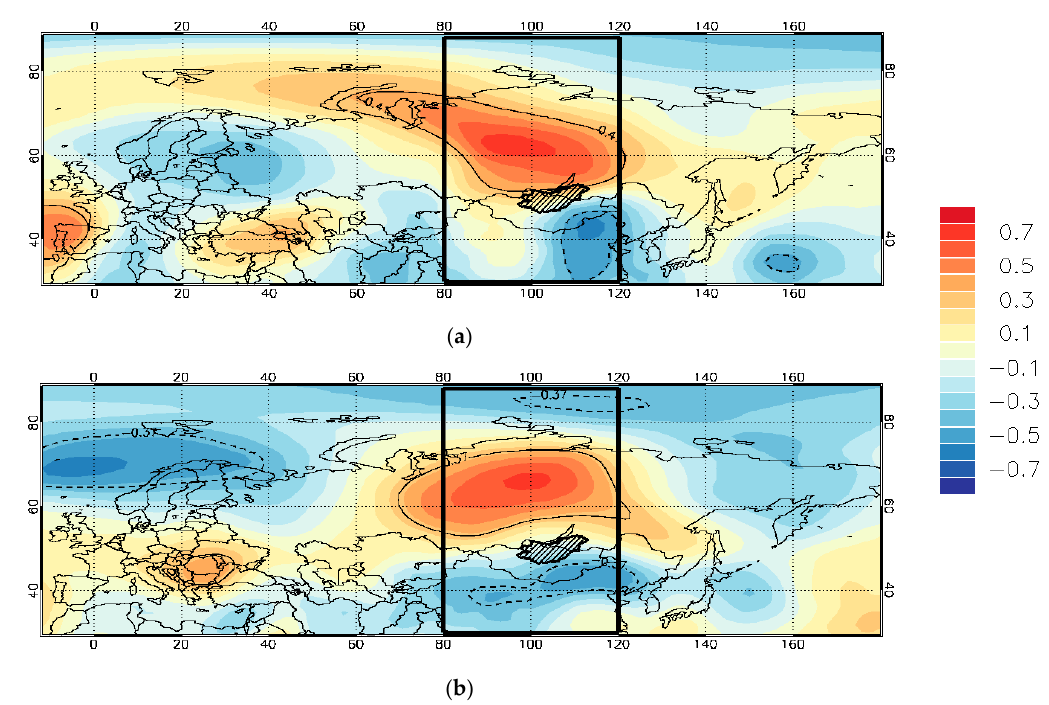
Figure 14. Correlation coefficients of ESM-BF and Z500 for 1979–1995 ( a ) and 1995–1996 ( b ). The description is the same as in Figure 8.